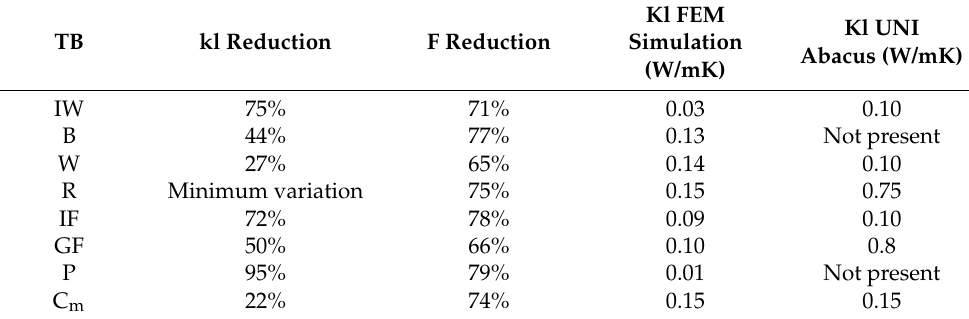
Table 16. Mitigation TB summary.